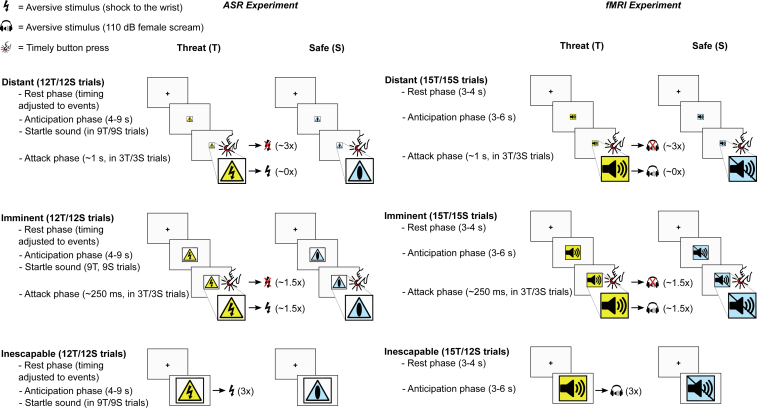
Outline of the TET for Both Human Experiments, Related to Figure 1Participants are repeatedly attacked by rapidly approaching pictures, which they can escape from by pressing a button. When they fail to do so they will be presented with an aversive stimulus (AS). The speed of attack is manipulated to be distant-escapable, imminent (with effort escapable at chance-level) or inescapable, and all conditions are compared to an equivalent safe-context control condition involving the same procedure but without the threat of AS exposure.